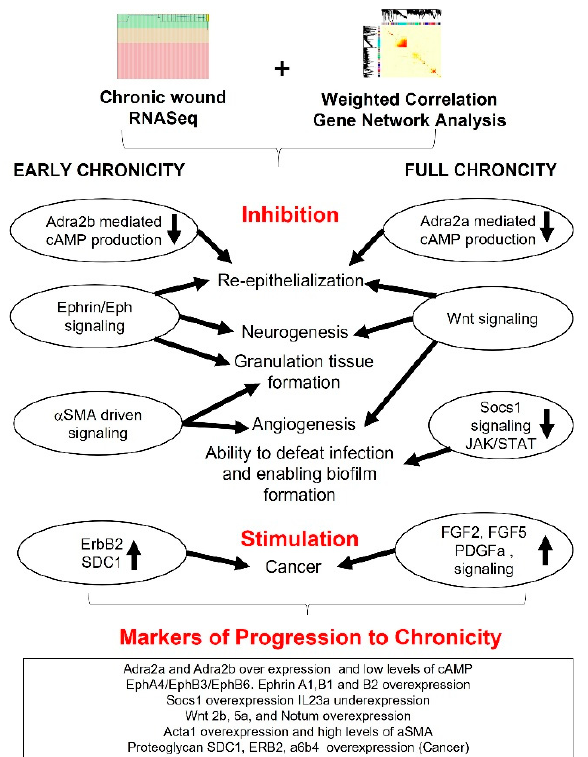
Figure 8. Progression to wound chronicity. For this study, we isolated mRNA extracted from chronic and non-chronic tissue. RNASeq was completed followed by analysis using WGCNA. WGCNA identified significantly correlated gene modules ( p < 0.05), which yielded significantly enriched (FDR < 0.05) signaling pathways in early and full chronicity. During early chronicity, Adra2b mediated lowering of cAMP production (impairs re-epithelialization and signal amplification), Ephrin/Eph signaling (impairs re-epithelialization, neurogenesis, and granulation tissue formation), aSMA-driven signaling (impairs granulation tissue formation and angiogenesis) were enriched. While in full chronicity, Adra2a mediated lowering of cAMP production, Wnt signaling (impairs re-epithelialization, granulation tissue formation and angiogenesis). Socs1 was upregulated which suppresses JAK–STAT signaling (subduing host immunity and enabling biofilm formation). In addition, overexpression of ErbB2/HER2 and SDC1 in early chronicity and Fgf2, Fgf5, and Pdgfa overexpression in full chronicity promote cancer-like